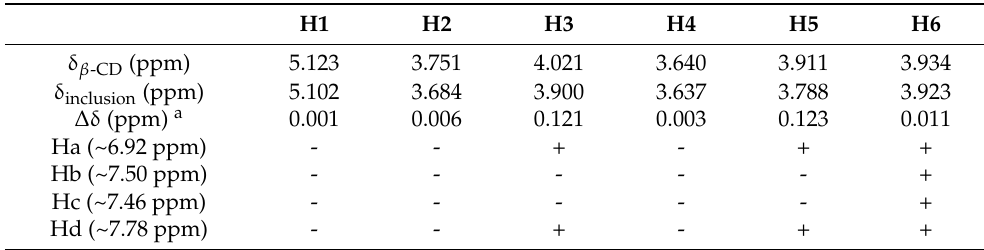
Table 2. 2D ROESY cross peaks (present (+) or absent (-)) and 1 H NMR chemical shift of β -CD, the inclusion complex of β -CD, and SA in D 2 O.